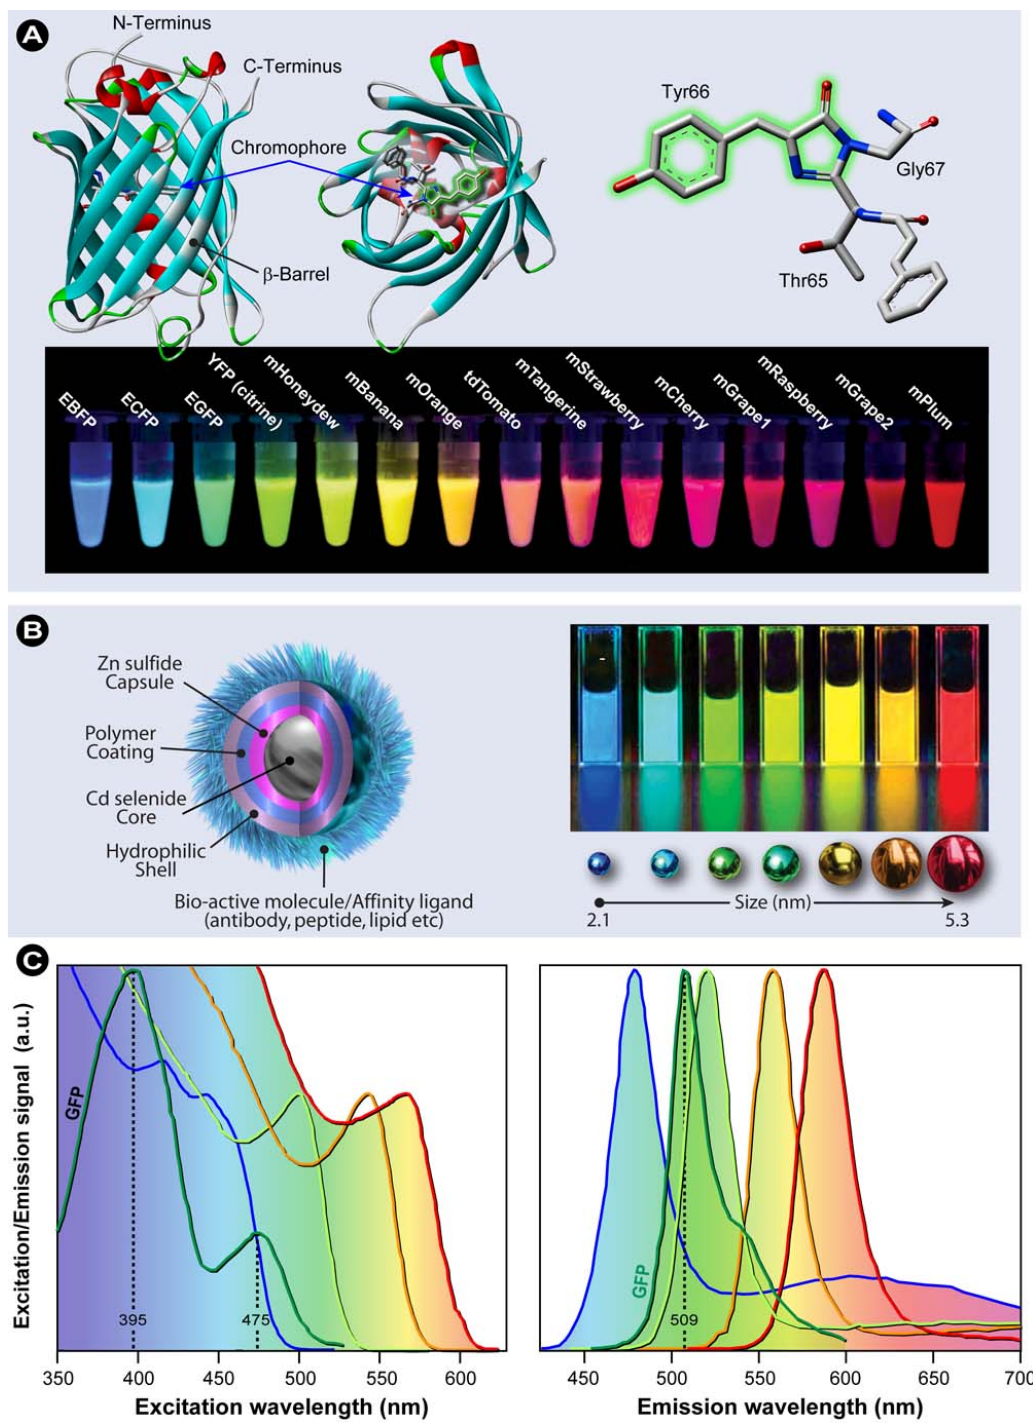
Figure 6. ( A ) Molecular structure and localization of the chromophoric tripeptide in A. victoria wild-type GFP. Notice that the tripeptide is located centrally within the  -barrel. A vast number of genetically enhanced (denoted “E”, e.g. , EGFP) and engineered FPs [27] have been created over the pasts decades. ( B ) Anatomy of a semiconductor quantum dot (QD), which derives its fluorescent properties from the bandgap between the inner core material and the capsule shell. QDs display size dependent fluorescent properties. ( C ) Excitation and emission spectra of A. victoria GFP (green lines) and examples of how the size influences the fluorescent properties of